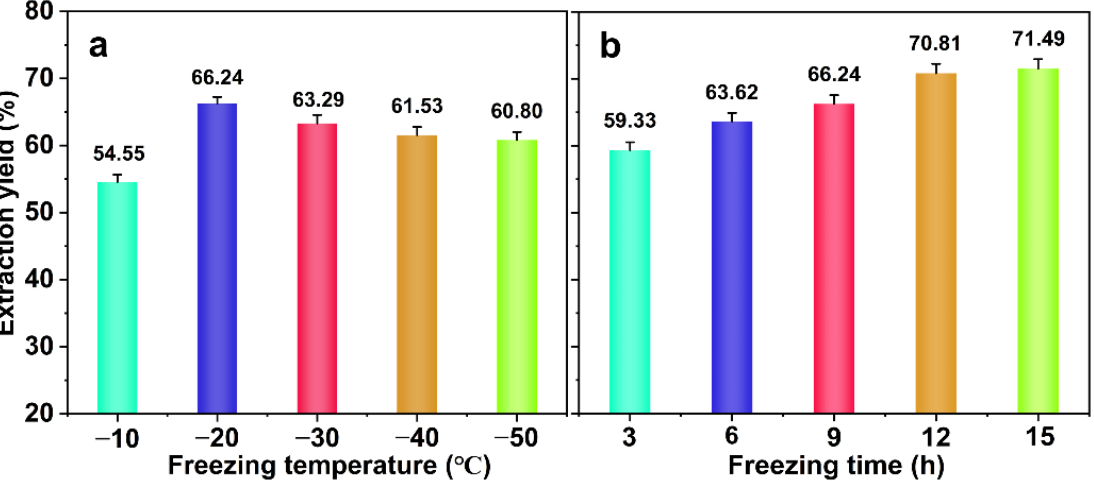
Figure 1. Effect of the freezing treatment on the extraction yield of hemicellulose ( a , effect of freezing temperature; ( b ), effect of freezing time. The error bars represent the mean ± SD of samples over three replicates).